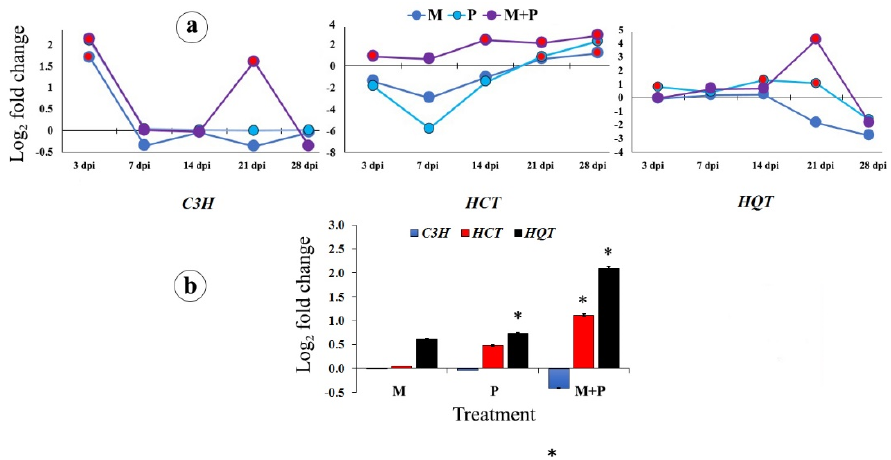
Figure 4. Change in the transcriptional expression of the chlorogenic acid biosynthetic pathway genes in sunflower leaves at 3, 7, 14, 21, and 28 dpi ( a ), and roots at 28 dpi ( b ) in response to colonization with R. irregularis and/or infection with R. solani . Where, M = colonized with R. irregularis , P = infected with R. solani , and M+P = colonized with R. irregularis and infected with R. solani . For each gene in the subfigure ( a ), treatments marked with red are significantly different at p ≤ 0.05. In the subfigure ( b ), bars indicate the standard error, and for each gene, columns superscripted with asterisks are significantly different at p ≤ 0.05.